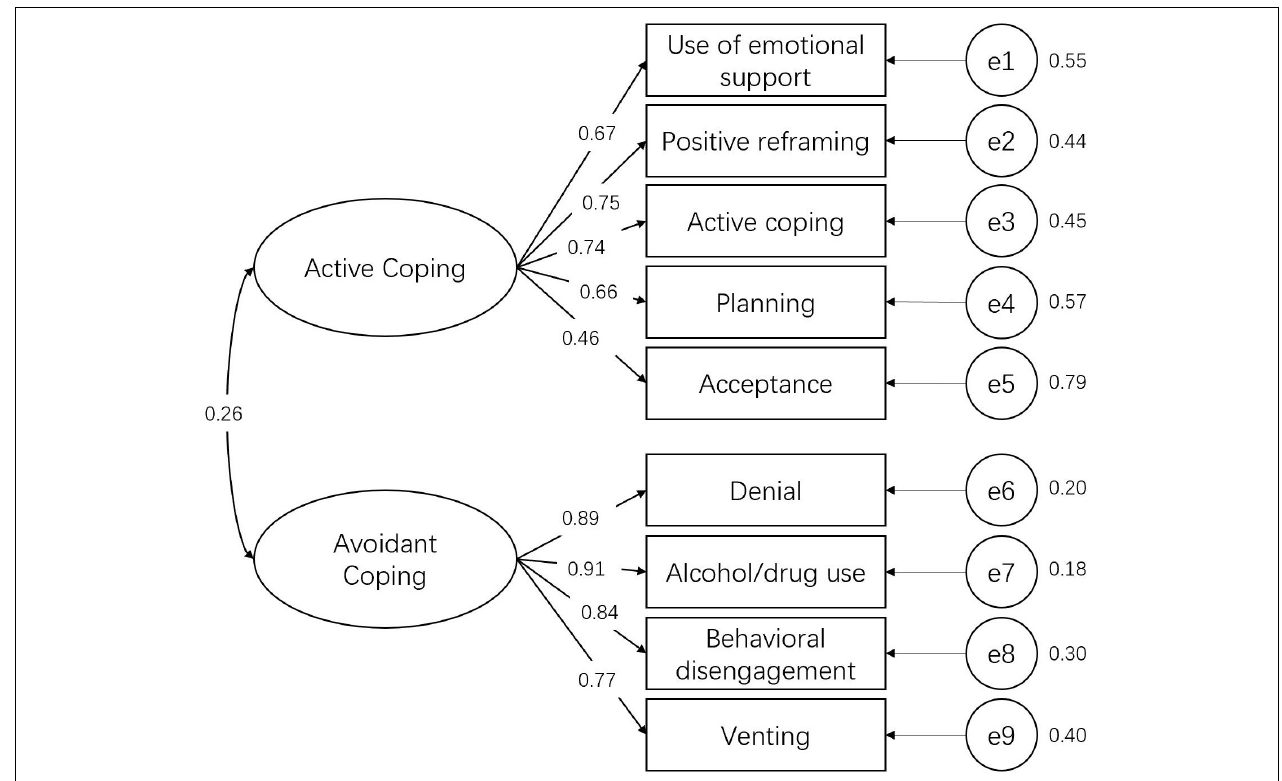
FIGURE 2 | The result of confirmatory factor